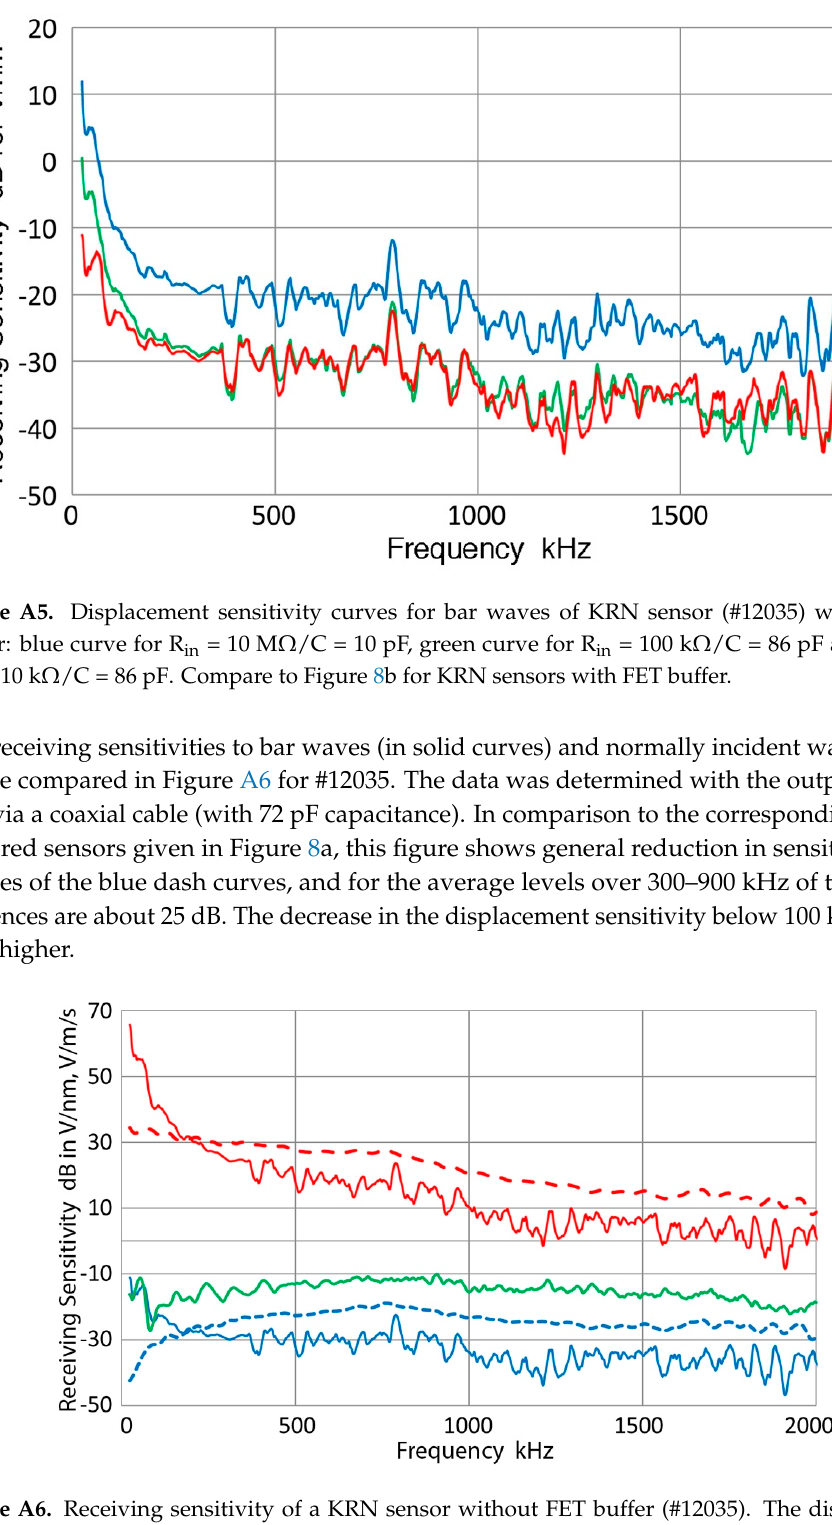
Figure A6. Receiving sensitivity of a KRN sensor without FET buffer (#12035). The displacement receiving sensitivities are shown in blue curves and velocity sensitivities are in red. Solid lines are for the bar-wave data, while dashed curves are for the sensitivities to normally incident waves. Compare to Figure 8c. Green curve is the high-impedance sensitivity to normally incident waves from reference [4].